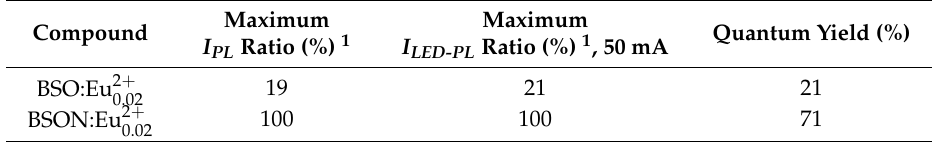
Table 3. Luminescent properties of phosphor materials.